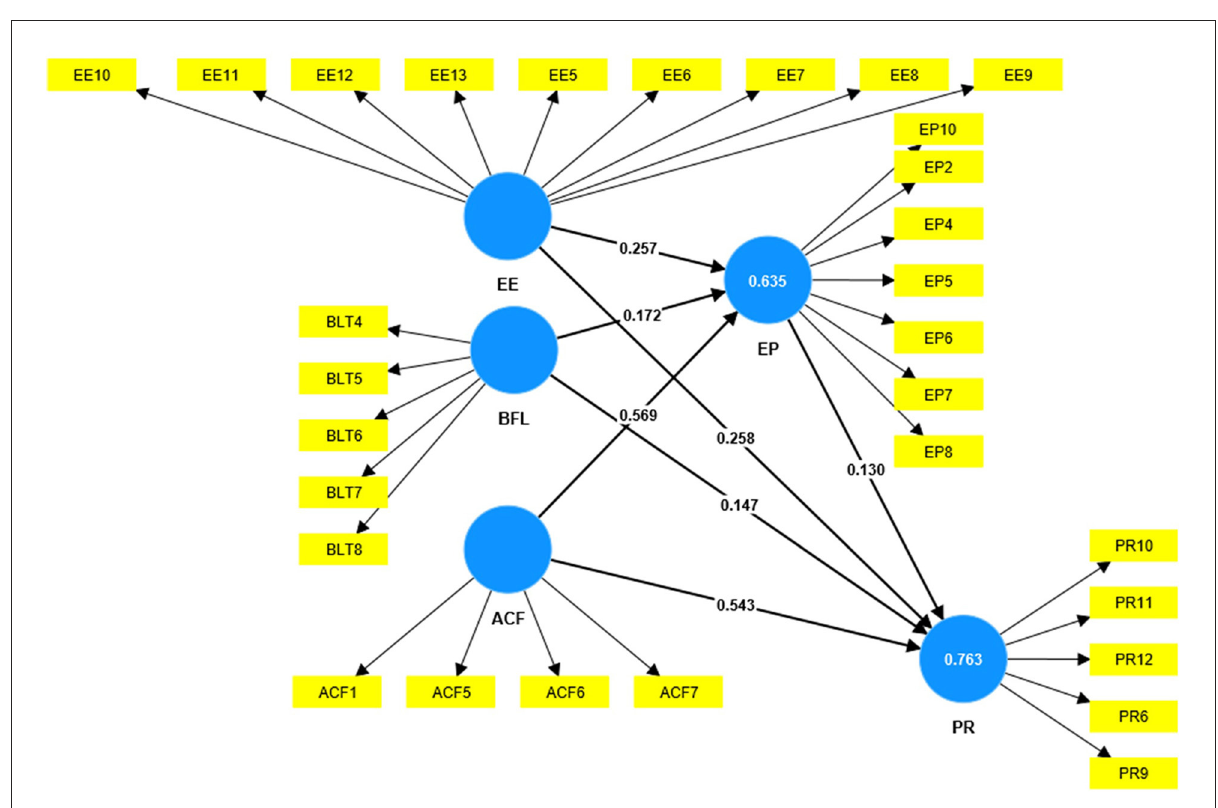
FIGURE2 The final